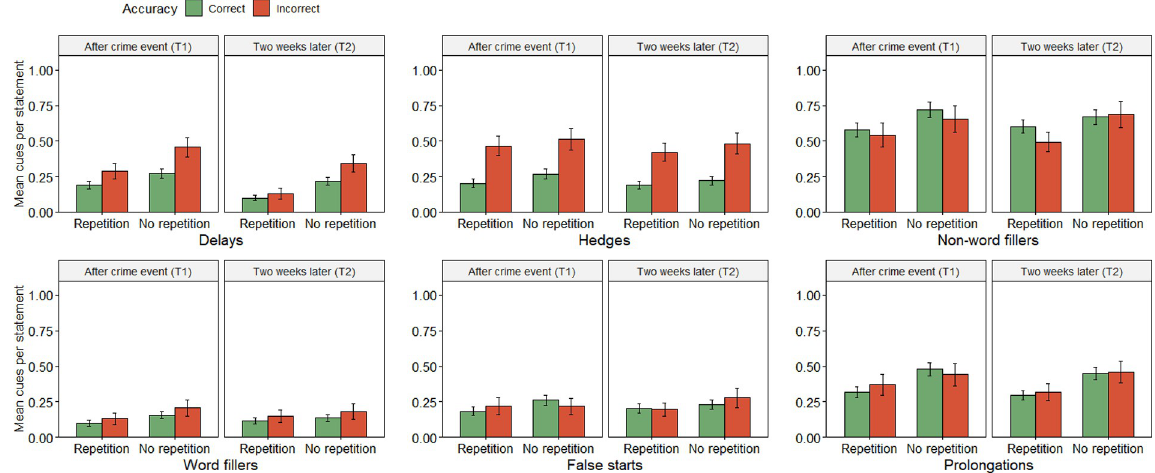
Fig 2. Effects of accuracy, time and repetition on retrieval-effort cues. Note. Error bars represent 95% confidence intervals.